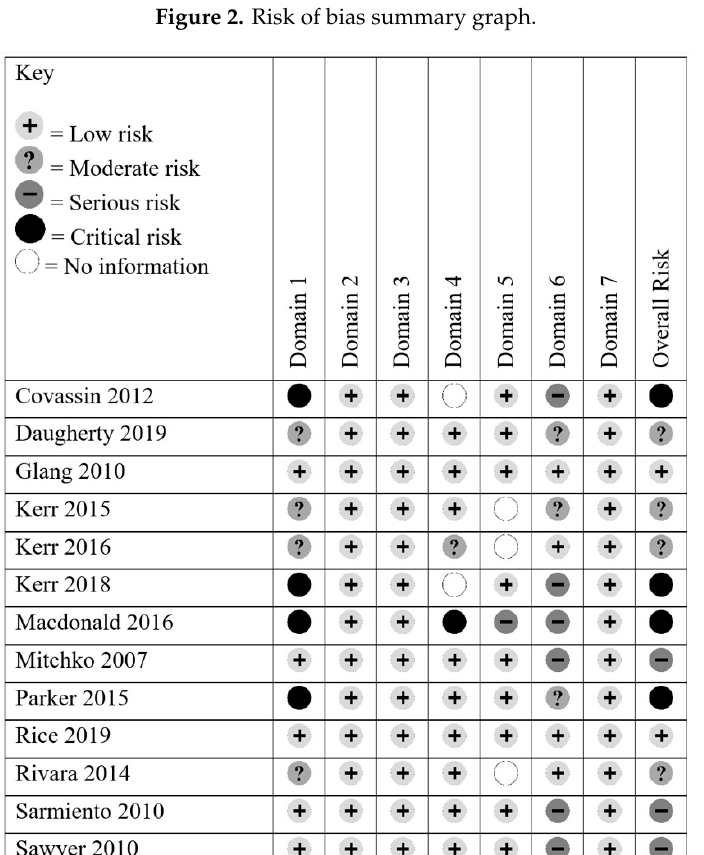
Figure 3. Risk of bias summary chart including judgements regarding risk of bias for all seven.